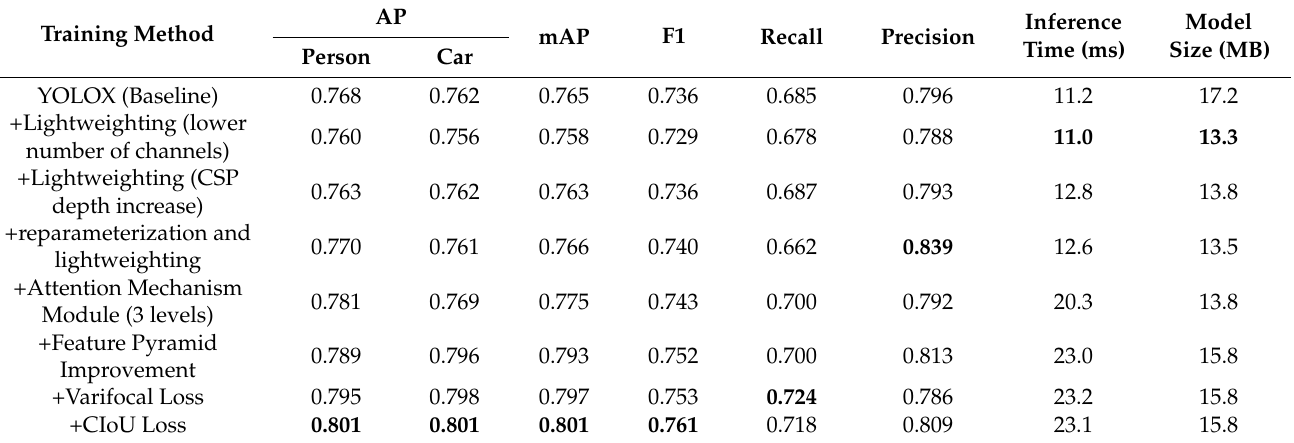
Table 2. Improved YOLOX algorithm for ablation experiments.